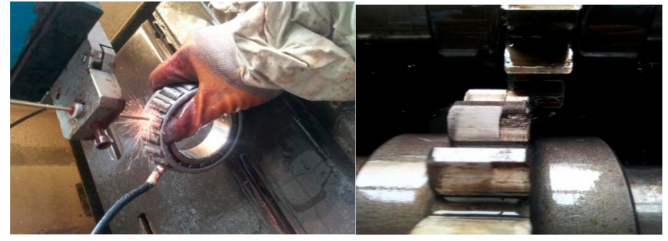
Figure 15. Bear and gear fault diagram.